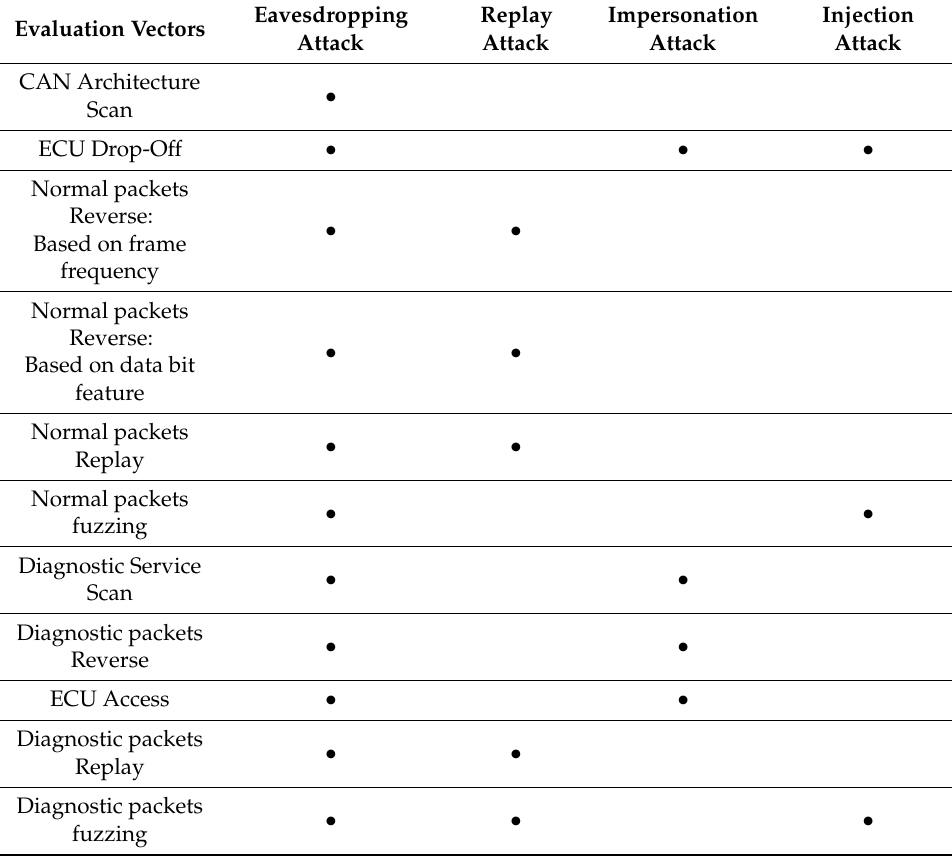
Table 2. Mapping between evaluation vectors and attack vectors.